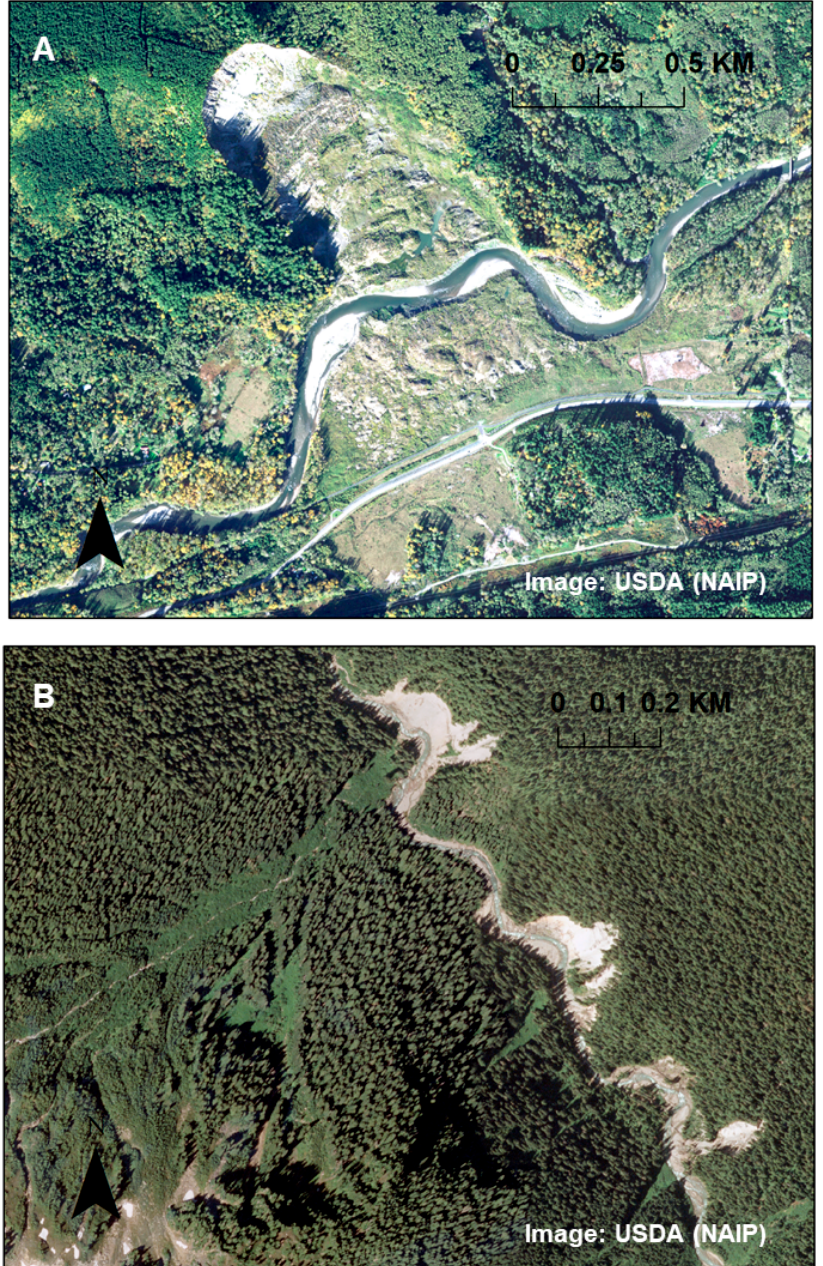
Figure 9. Process interaction in fluvial systems: lateral channel activity (channel-valley floor connectivity) leads to slope toe undercutting, triggering or contributing to slope failures (hillslope-channel connectivity). ( A ) Large, deep-seated landslide along Stillaguamish River, WA. ( B ) Smaller slides along White Chuck River, WA. Image credit: USDA (NAIP).